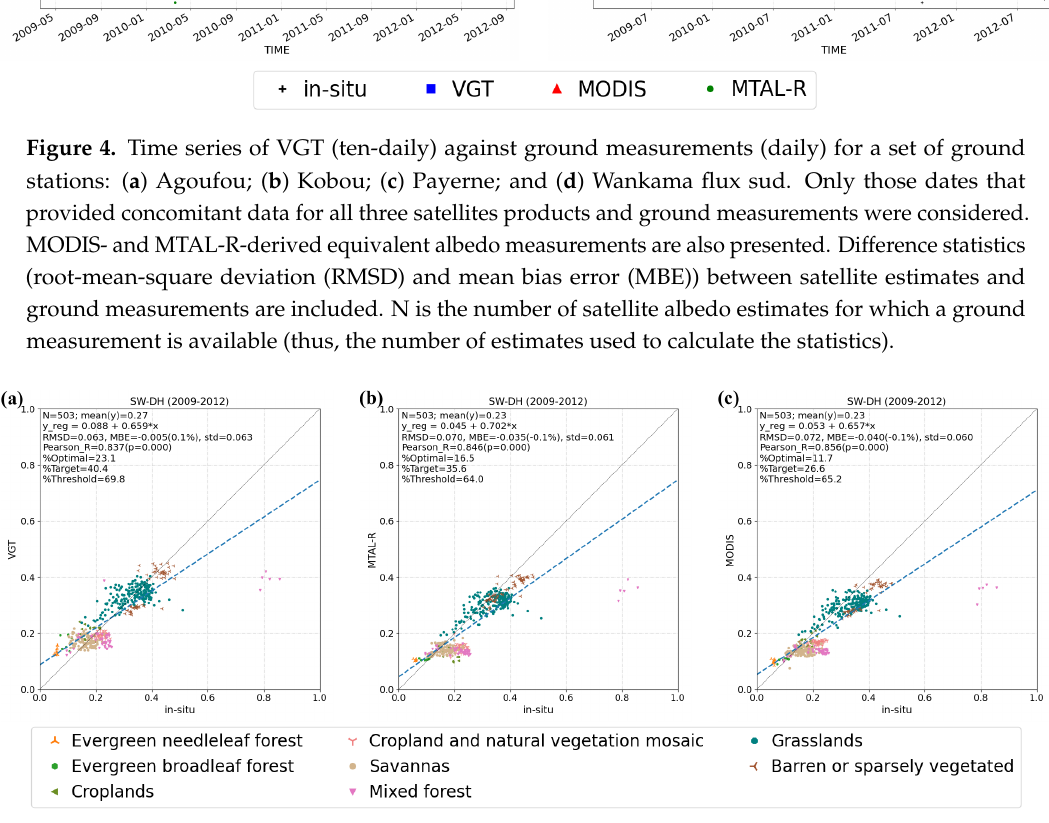
Figure 5. Accuracy assessment of ( a ) VGT, ( b ) MTAL-R and ( c ) MODIS surface albedo satellite products versus ground measurements coming from GBOV, AMMA and BSRN stations during the 1 January 2009–31 December 2012 period. Only those dates that provided concomitant data for all three satellites products and ground measurements were considered. The continuous black line corresponds to the 1:1 line. The blue dashed line corresponds to the regression